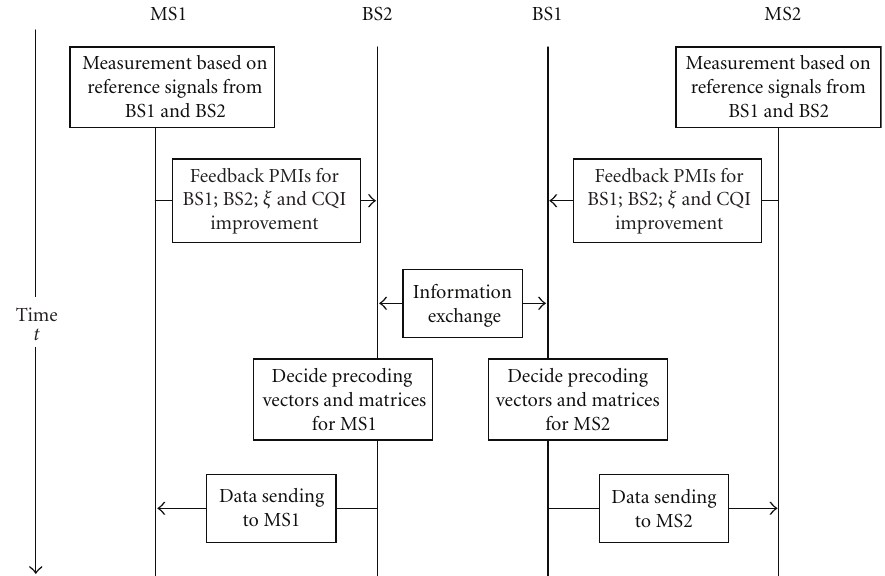
Figure 2: Time line of proposed inter-cell interference coordination through limited feedback.